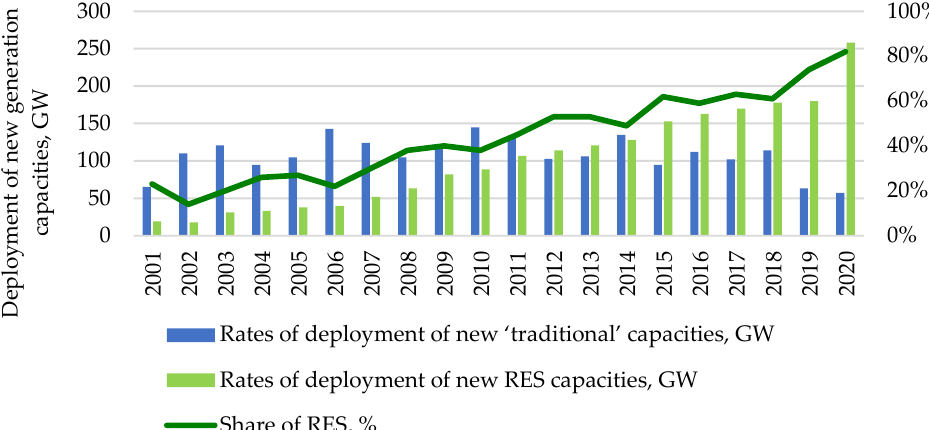
Figure 4. Comparison of the rates of deployment of new generation capacities (traditional and RES) (based on [28]).